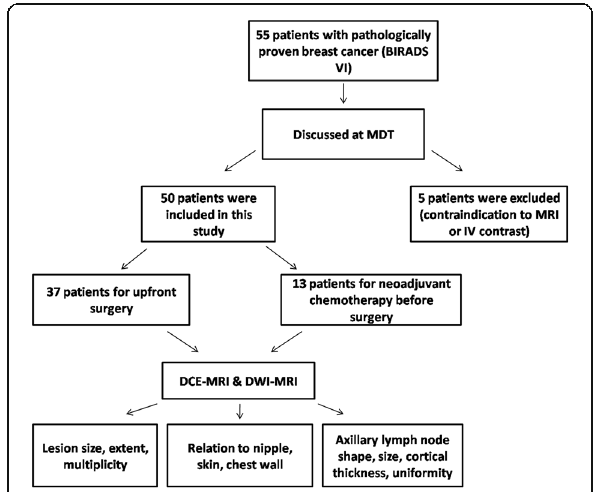
Fig. 1 Flowchart of the study group and